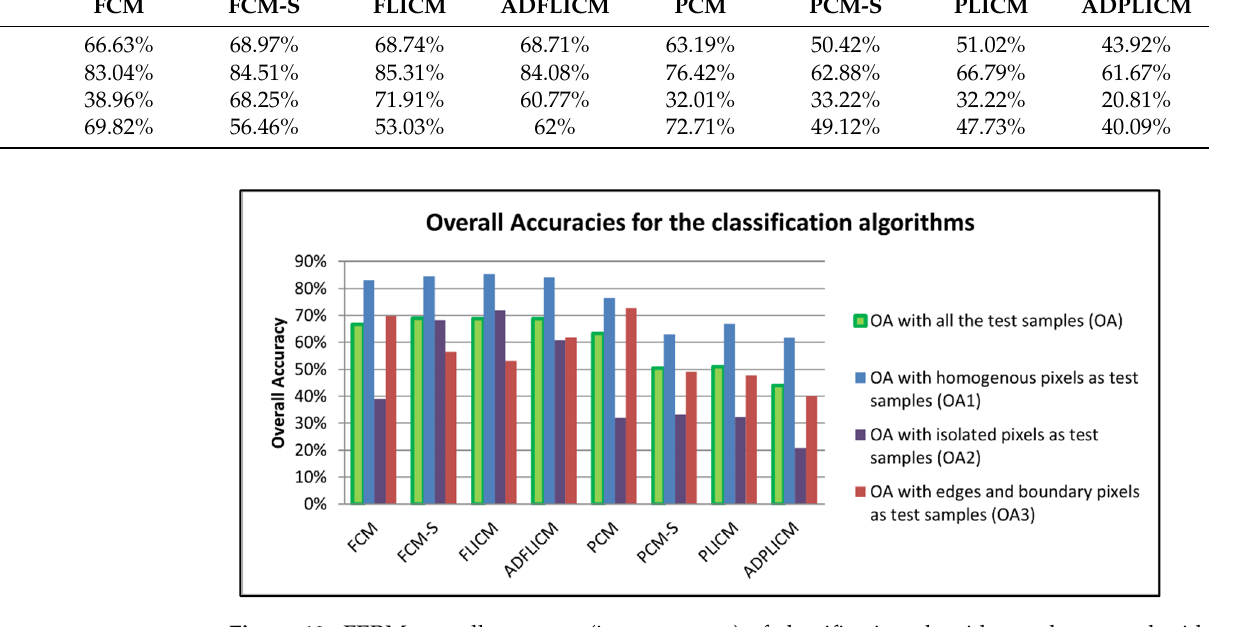
Figure 10. FERM overall accuracy (in percentage) of classification algorithms when tested with different sample sets.